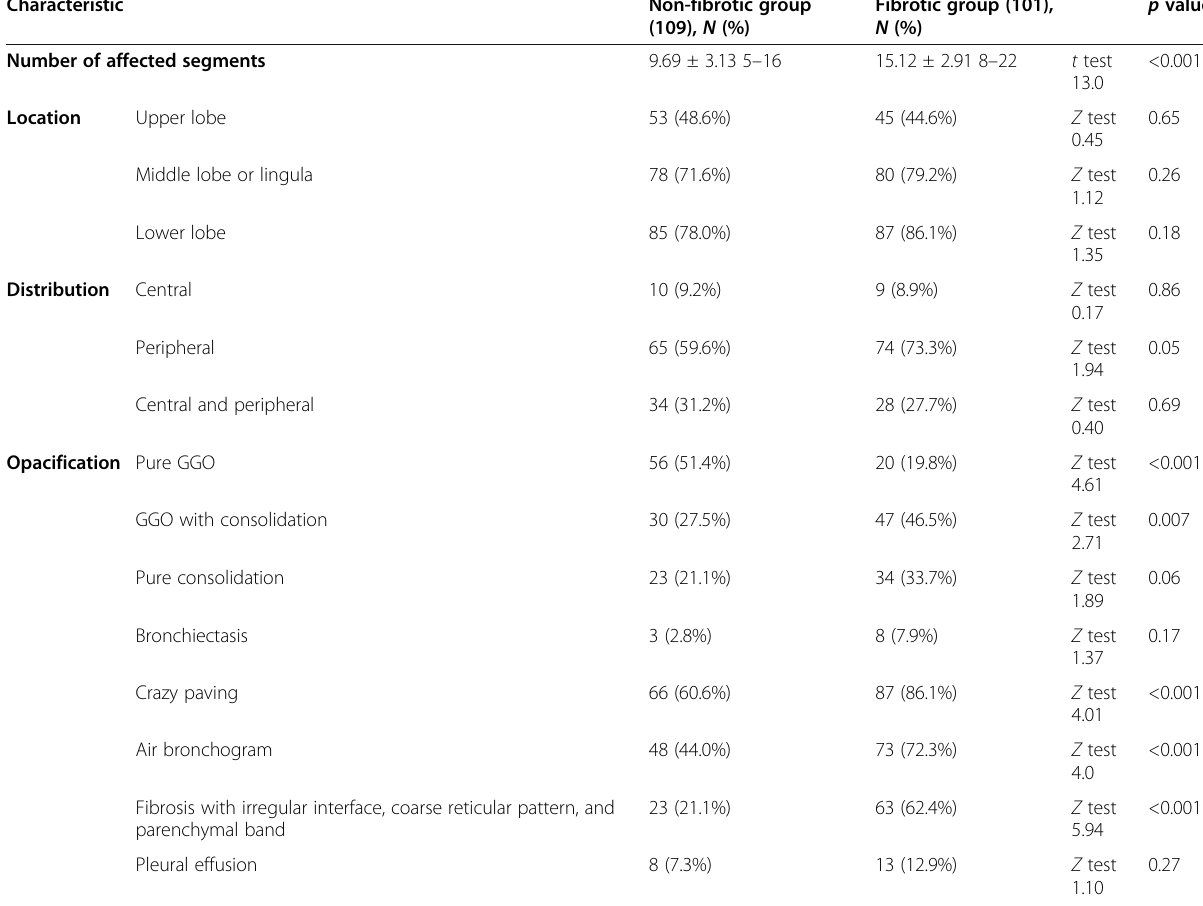
Table 2 Comparison of particular characteristics between the groups on peak CT imaging